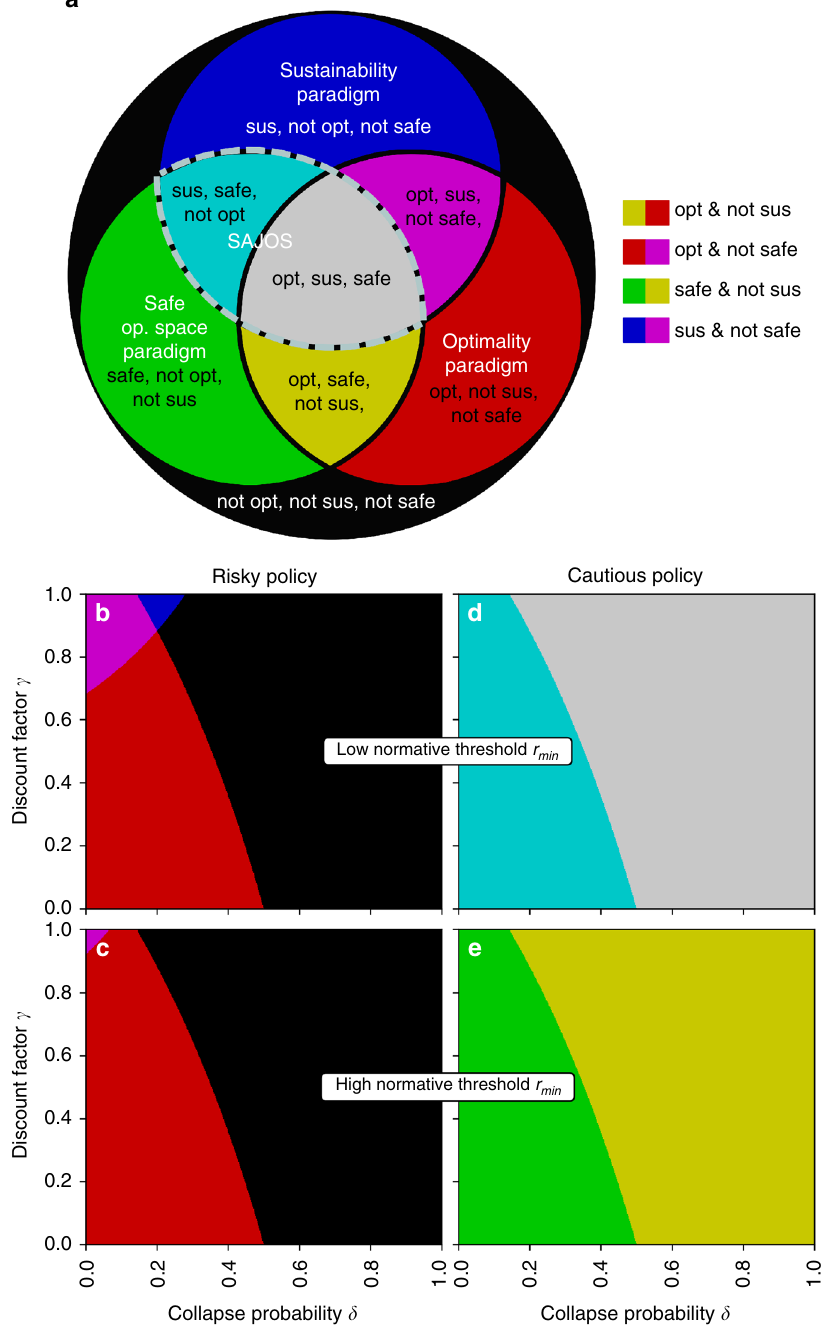
Fig. 3 Paradigms classi fi cation for risky and cautious policy. There exist policies in parameter space of our model for all logical combinations of paradigm classi fi cations. a i.e. a policy can be any combination of (not) optimal, (not) sustainable and (not) safe. Remaining parameters where chosen as ρ = 0.2, r l / r = 0.5 for illustration purposes (c.f. Methods). For a suf fi ciently low normative threshold value r h Space (SAJOS) exists, which we identi fi ed as the overlap of safe and sustainable policies b , d (gray and cyan area). For a suf fi ciently large r min > r l (here r = 0.7) a SAJOS does not exist c , r min / h